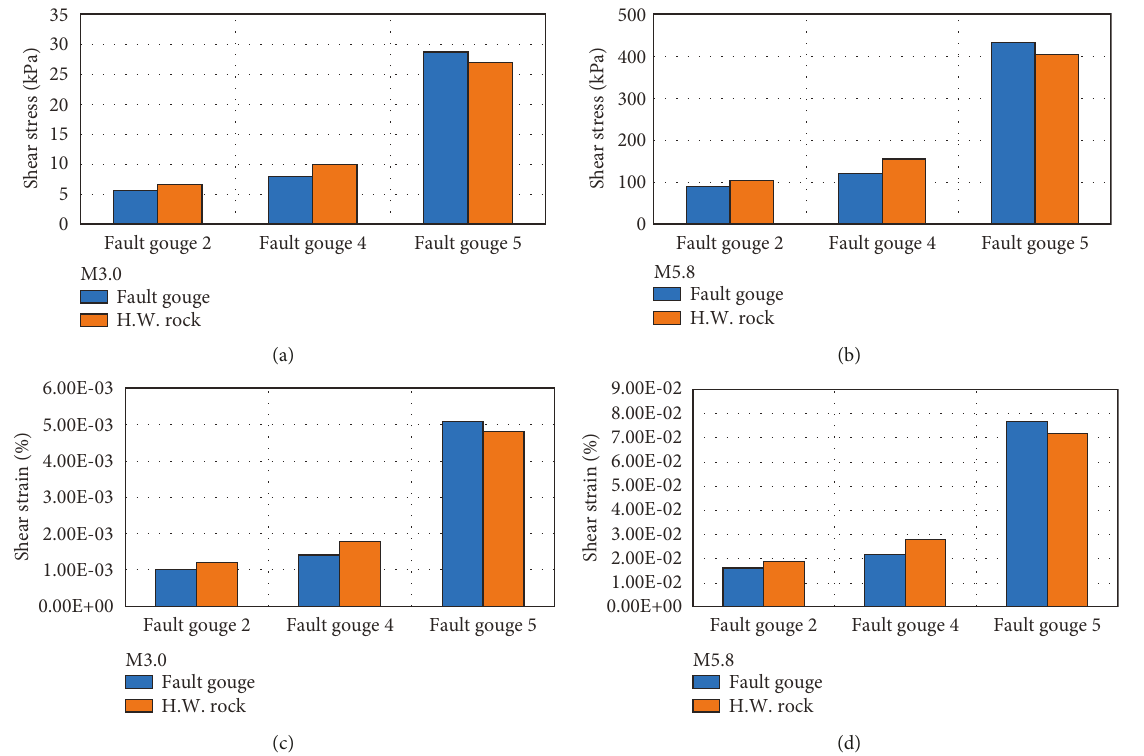
Figure 13: Comparison of the maximum shear stress and shear strain between fault gouge in sedimentary rock and H.W. rock due to the (a) M3.0 and (b) M5.8 earthquakes. There is a similar tendency in all of the fault gouges, regardless of magnitude. (a) Maximum shear stress due to the M3.0 earthquake. (b) Maximum shear stress due to the M5.8 earthquake. (c) Maximum shear strain due to the M3.0 earthquake. (d) Maximum shear strain due to the M5.8